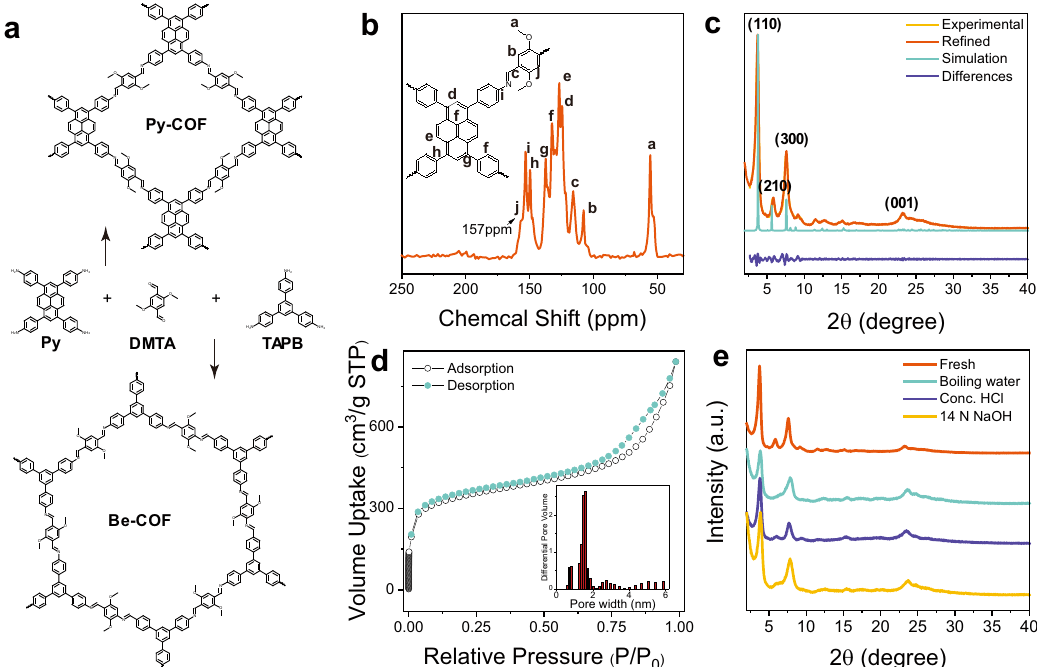
Fig. 1 Synthesis, characterization and stability test of COFs. a Synthesis of Py-COF and Be-COF by the condensation of DMTA with Py and TAPB, respectively. b 13 C-CP/TOSS NMR spectrum, c Experimental, Pawley-re fi ned and simulated PXRD patterns (AA stacking) and difference plot, d N 2 adsorption isotherm and pore size distribution and e PXRD patterns of Py-COF before and after treatment in boiling water, 12 N HCl and 14 N NaOH for 3